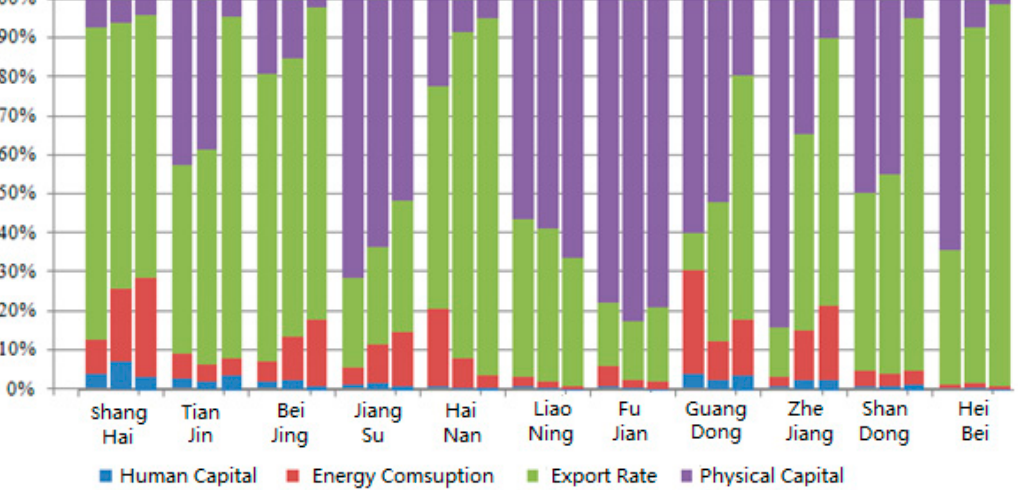
Figure 6. Contribution of variables to FDI performance in the east region.